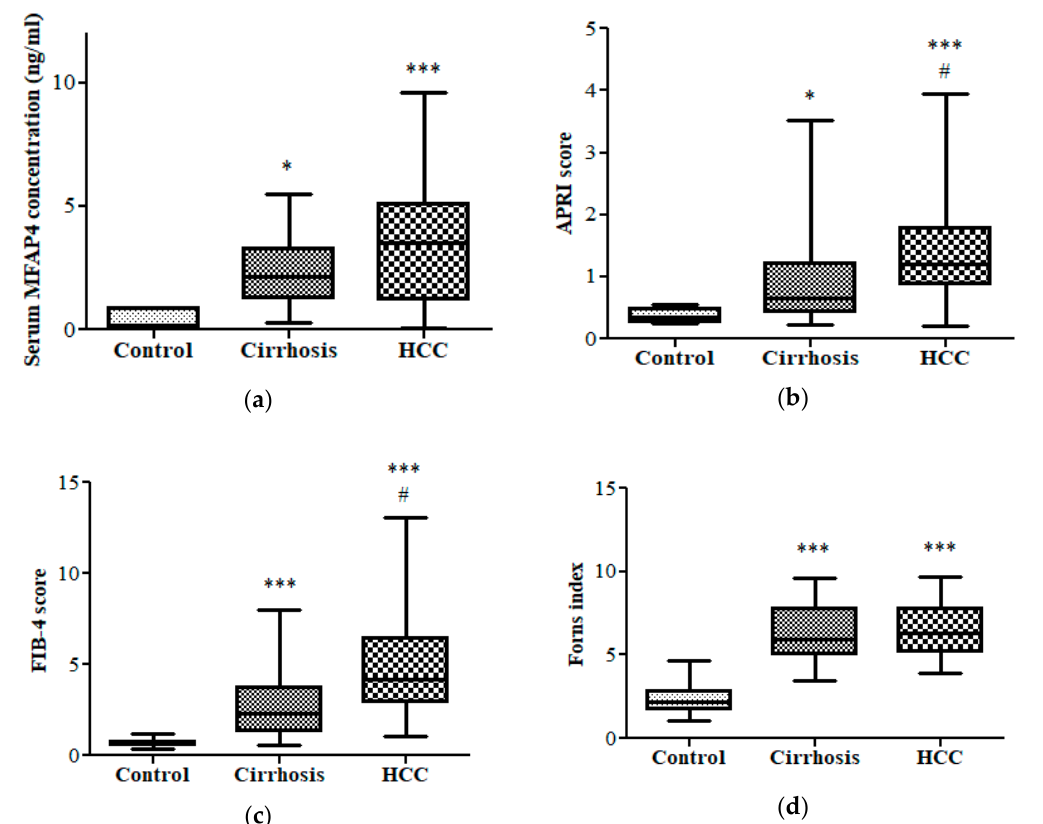
Figure 2. ( a ) Serum microfibrillar-associated protein 4 (MFAP4) concentration (ng/mL) in cirrhotic, hepatocellular carcinoma (HCC) patients and control group; ( b ) Aspartate aminotransferase to platelet ratio index (APRI) in cirrhotic, HCC patients and control group; ( c ) Fibrosis index based on the 4 factors (FIB-4) in cirrhotic, HCC patients and control group; ( d ) Forns index in cirrhotic, HCC patients and control group. Kruskal-Wallis test was used. Values were expressed as median (interquartile range). * = Significance against control group ( p < 0.05); *** = Significance against control group ( p < 0.001); # = Significance against cirrhotic group ( p < 0.05).